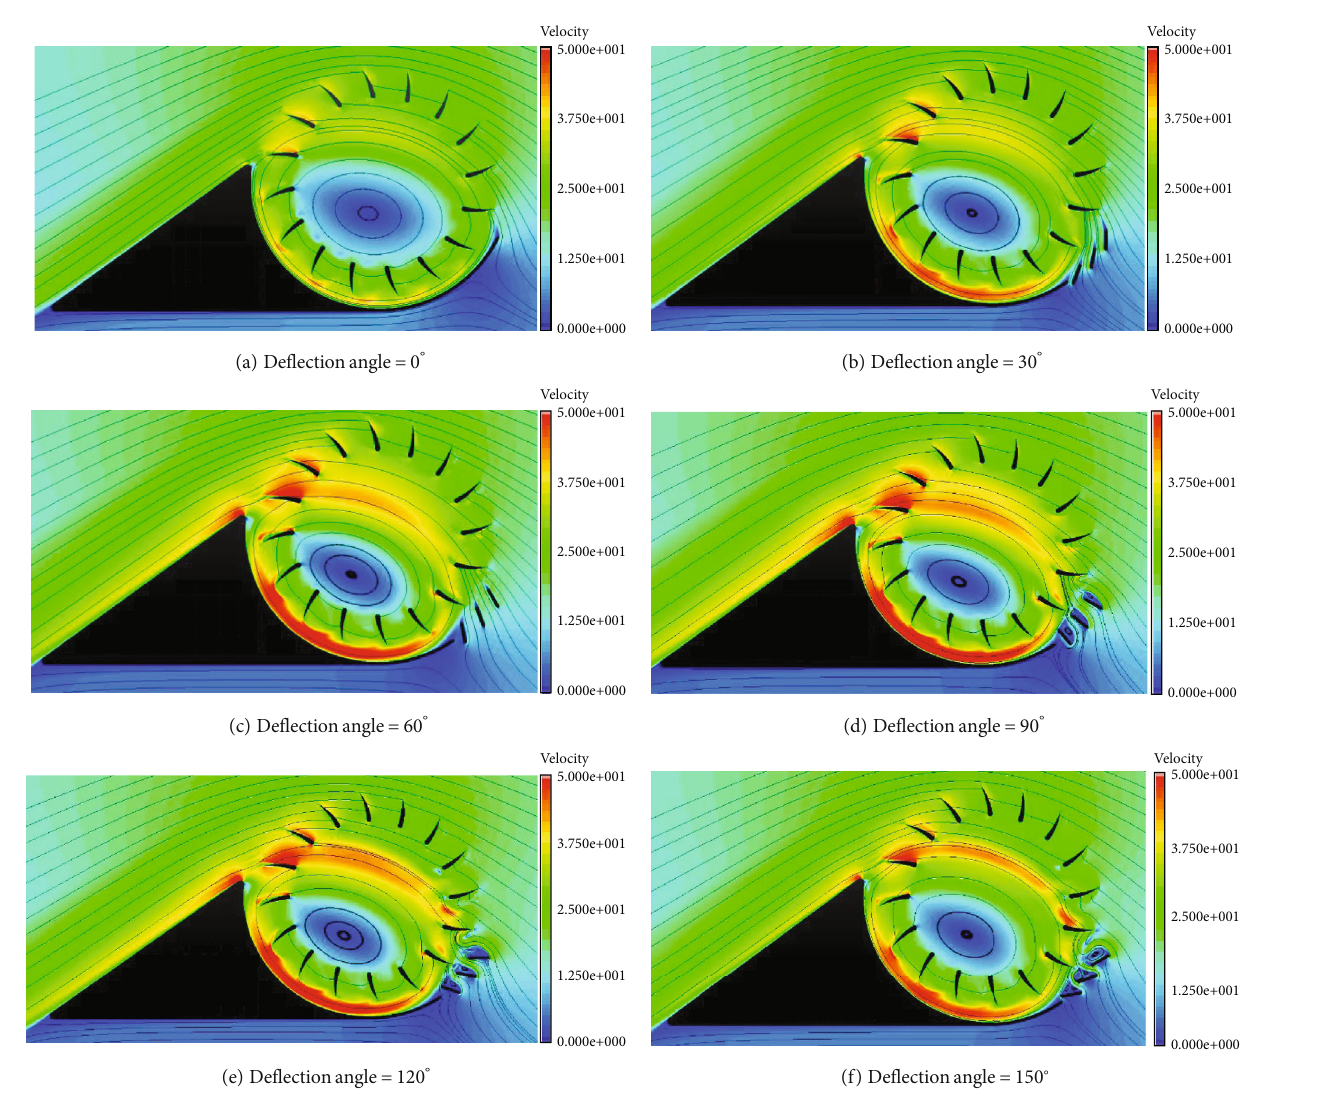
Figure 17: Velocity nephogram and streamline diagram of a single leading edge winglet ( v = 12 m/s, α = 0 °